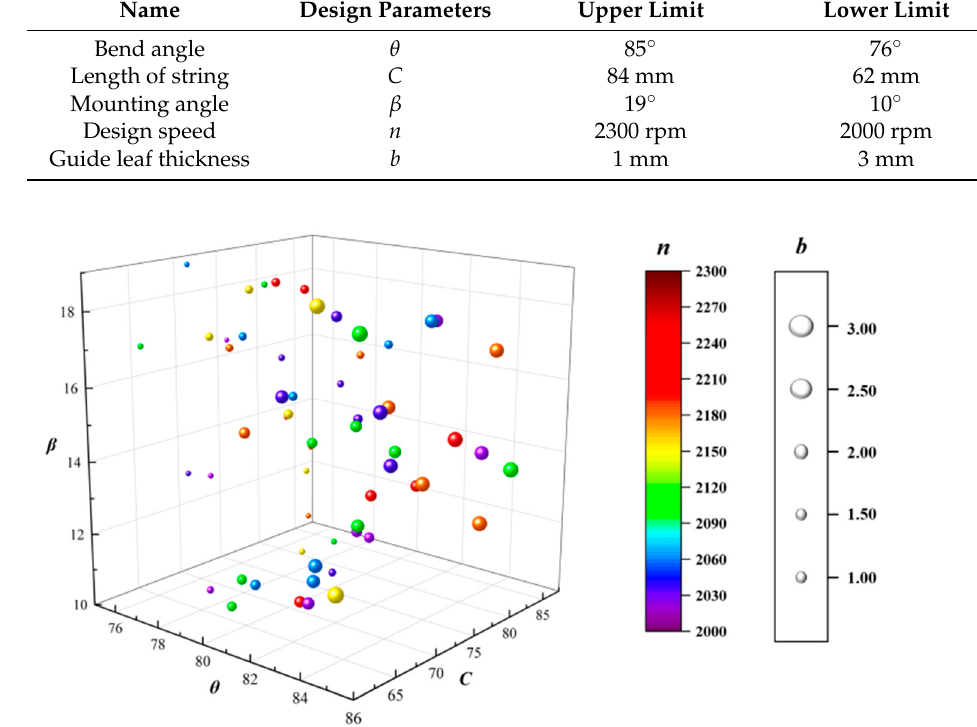
Figure 9. A sampling of 60 original samples.